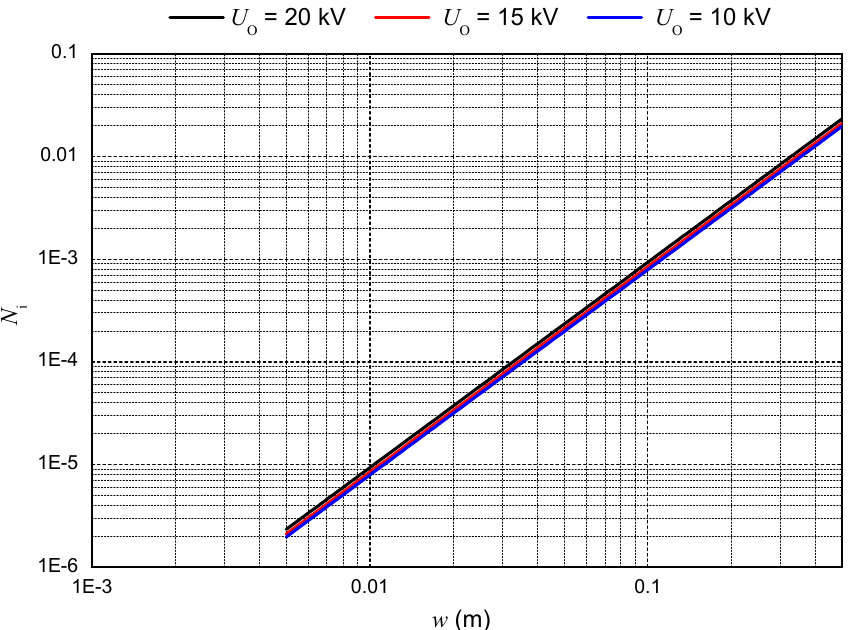
Figure 9. Frequency of damage N I to apparatus as a function of the distance w between conductors of the LV circuit.